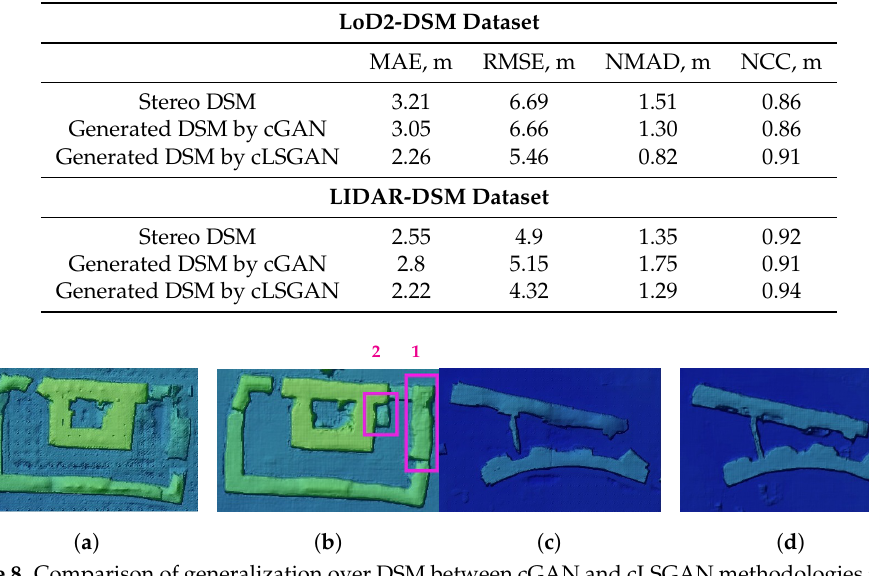
Figure 8. Comparison of generalization over DSM between cGAN and cLSGAN methodologies for two selected buildings. ( a , c ) are the generated buildings by cGAN and ( b , d ) are the generated buildings by